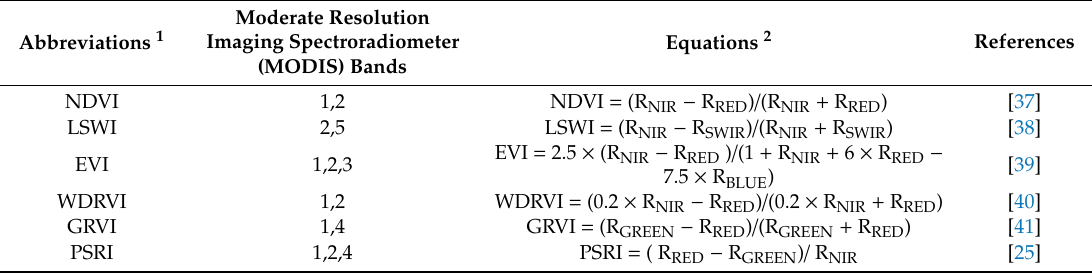
Table 1. Descriptions of vegetation indices used in this